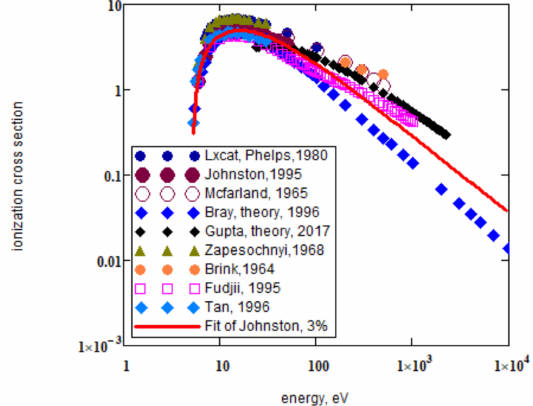
Figure 3. Electron impact ionization cross sections of sodium in Å 2 .